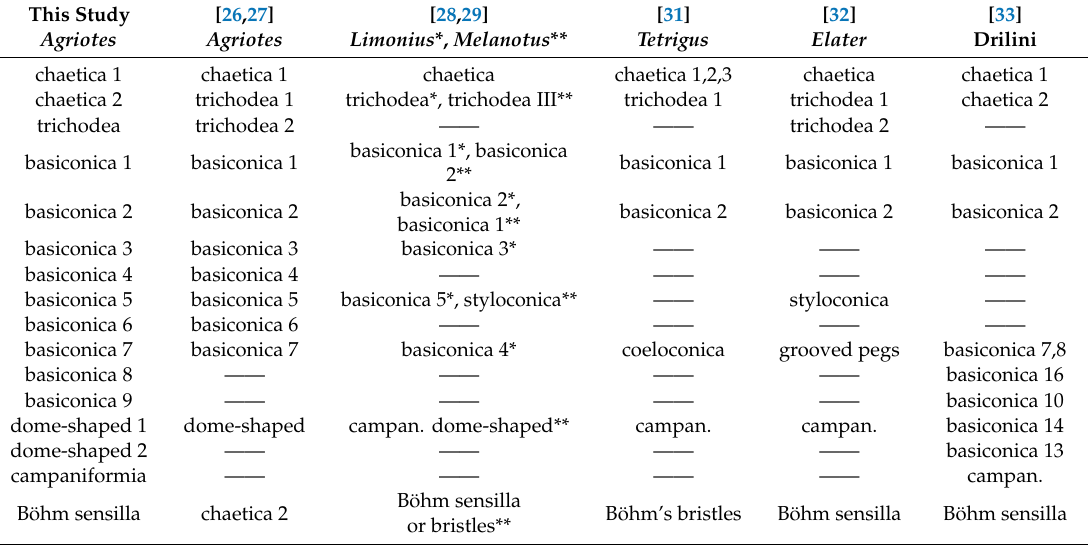
Table 5. Sensillum types and subtypes in Elateridae by di ff erent authors. campan.,